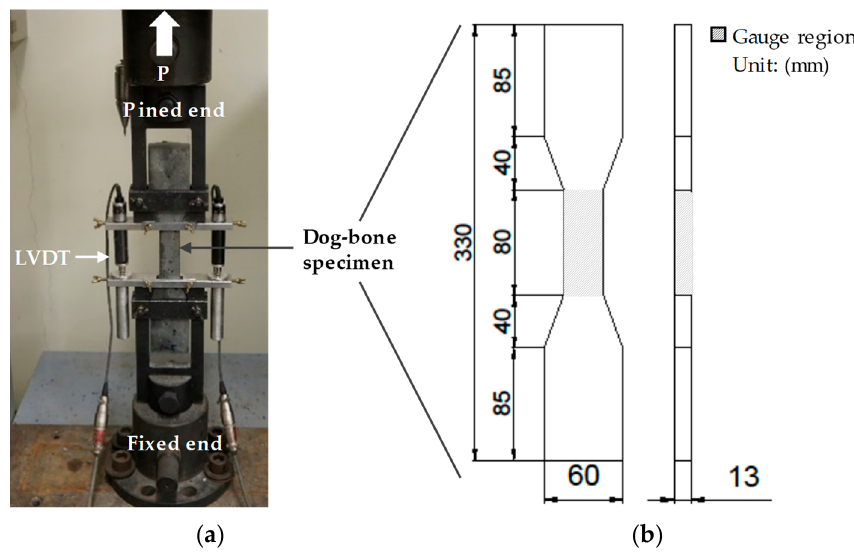
Figure 2. Japan Society of Civil Engineers (JSCE) direct tensile test: ( a ) test setup and ( b ) specimen detail.